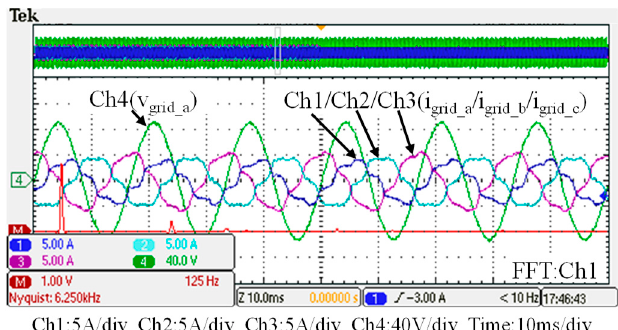
Figure 21. Before t 1 : the grid phase-a voltage and three-phase currents and the fast Fourier transform (FFT) waveform of the grid phase-a current.